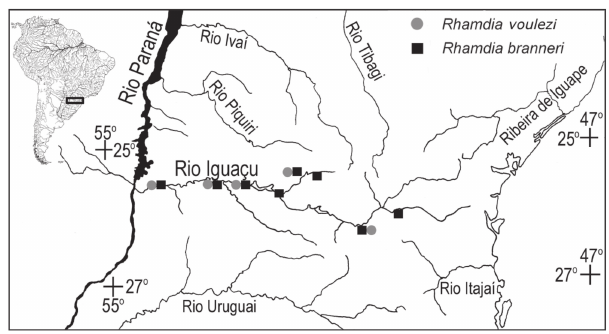
Fig. 5. Geographical distribution of Rhamdia branneri and R. voulezi in rio Iguaçu. Each symbol may represent more than one sample.